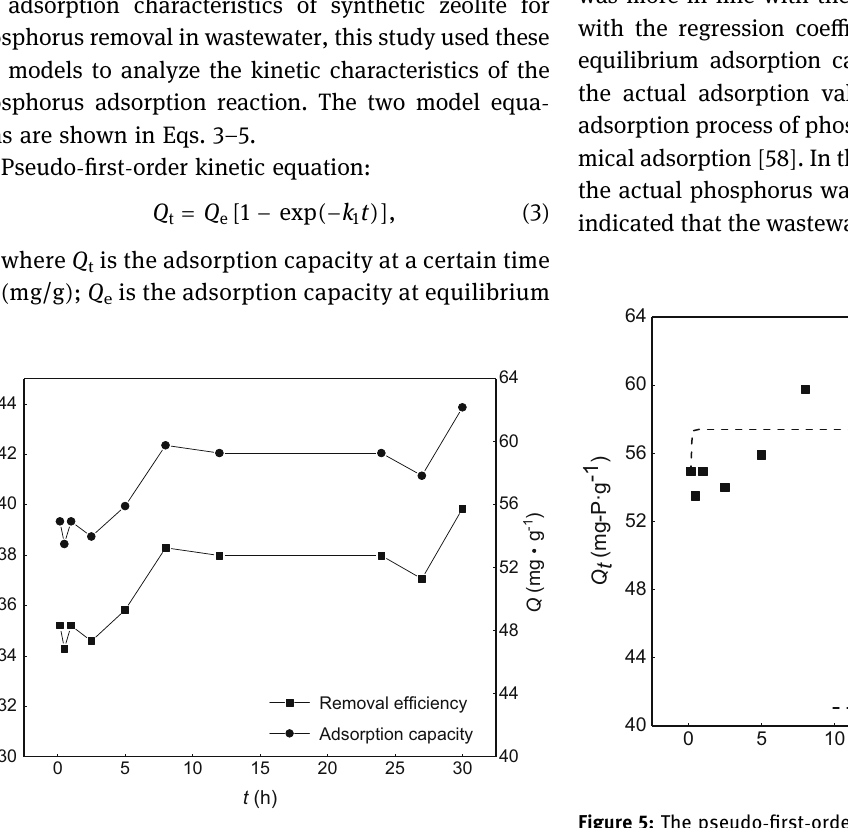
Figure 4: E ff ect of time on phosphorus removal.